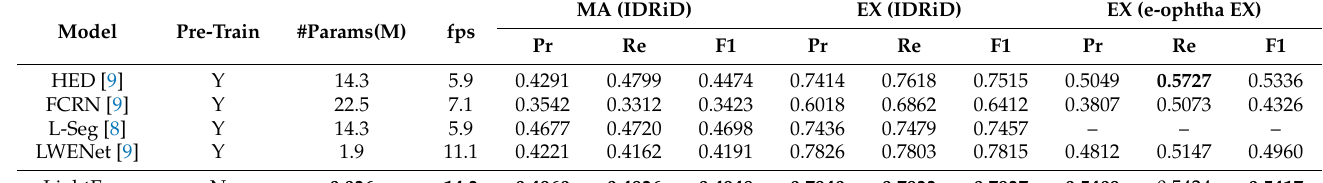
Table 4. Comparison of the LightEyes and other models on lesion segmentation (fps = 1/ t i , where t i